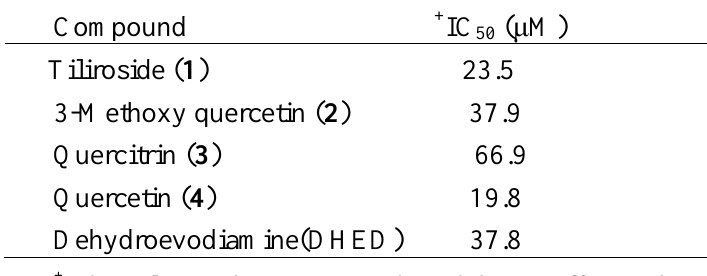
Table 1 . The inhibitory activities of compounds 1-4 on